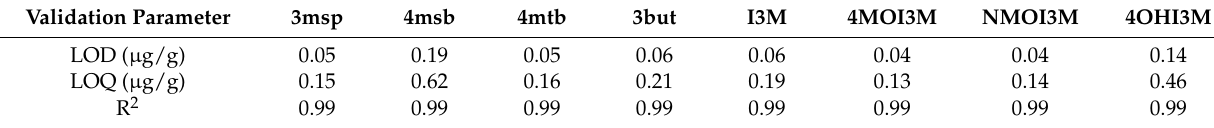
LODs were in the range of 0.04 to 0.19 µg/g and LOQs ranged from 0.13 to 0.62 µg/g (Table 3). The calibration graph for each target analyte was a straight line with coefficient of correlation values (R 2 ) above 0.99 in all cases (Supplementary Figure S5). No carry-over effect was observed for any of the analytes of interest, indicating that none of the target intact glucosinolates was retained on the column after separation was complete. Table 3. Limit of detection (LOD), limit of quantification (LOQ) and coefficient of determination (R 2 ) values. Validation Parameter